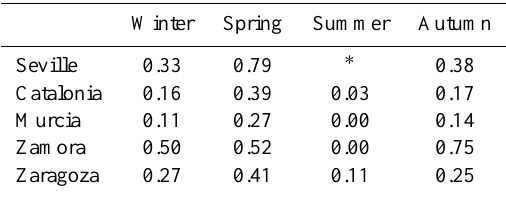
Fig. 4. Rogation series seasonality at the seven analysed sites.